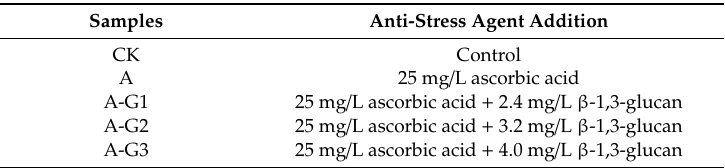
Table 1. Experimental design for exposure to anti-stress agents of live tiger grouper during simulated transport in